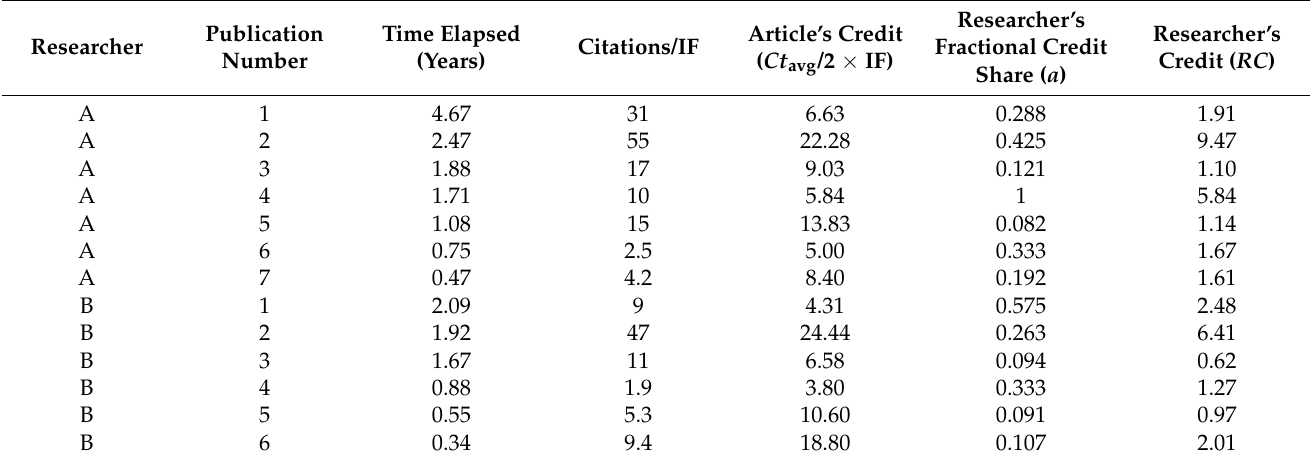
Table 6. Evaluation of articles’ credits, fractional credit shares, and researchers’ credits against the details provided in Table 4. k =